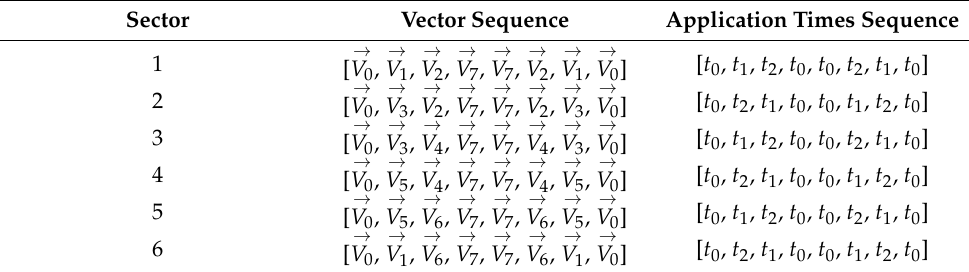
Table 2. Seven-segment switching sequence and application